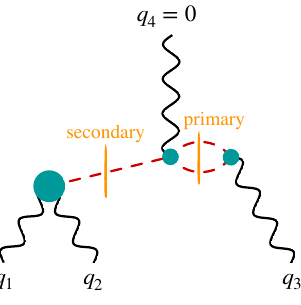
Figure 17. Dispersion relation for the HLbL tensor in the ( g (cid:0) 2) (cid:22) kinematic limit with singularities from primary and secondary channels (2 (cid:25) state and pseudoscalar